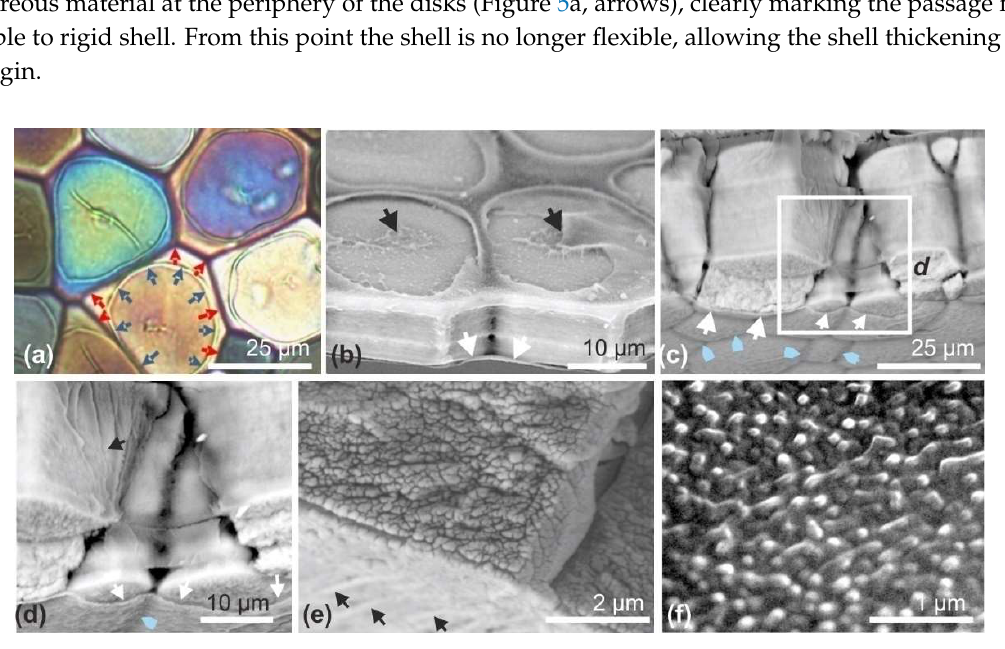
Figure 5. The newly formed prisms and the Marsh and Sass membrane on the internal side of the shell of Pinctada . ( a ) Sealing of the remaining spaces between disks. ( b ) Two neighbor prisms starting their inward growth by synchronic mineral deposition. On their outer surfaces, early decay of the periostracum reveals the positions of the initial nodules. Note the Marsh membrane on the internal side of the prisms. ( c , d ) Enlarged views of some prisms showing their internal side covered by the Marsh membrane. ( e ) Close adherence of the Marsh membrane to the mineralized material of the prism. Note the parallel striation of the outer side of the Marsh membrane (arrows). ( f ) Granular morphology of the Marsh membrane.